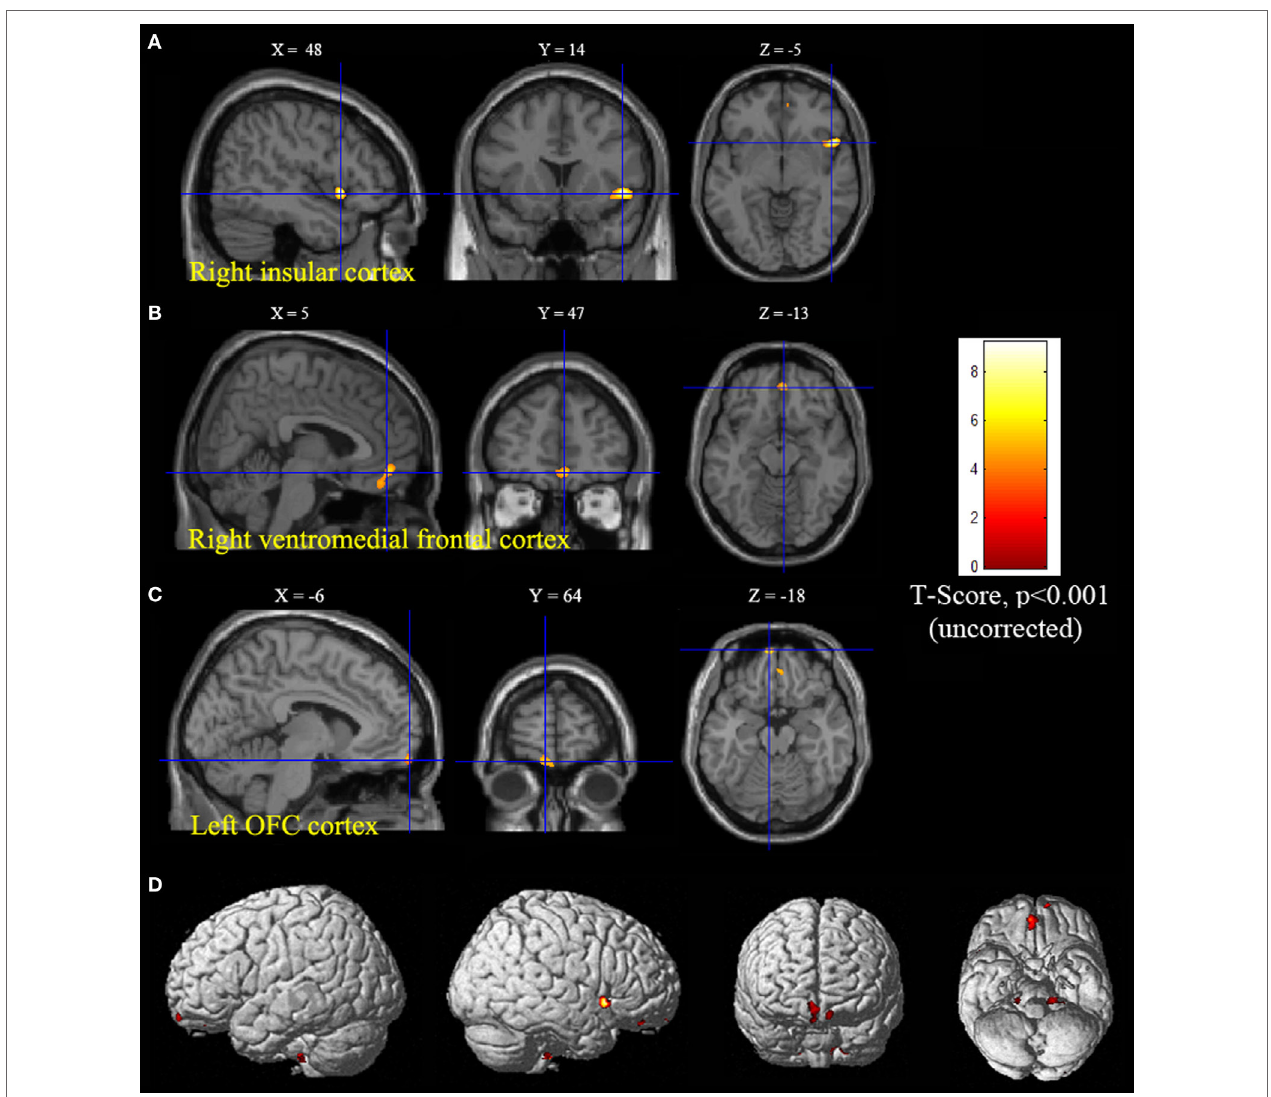
FigUre 4 | Significant hypometabolism in patients with HMS1, in comparison to patients with HMS2. More extensive hypometabolic areas in HMS1 than HMS2 were found, including right insular cortex (a) , right ventromedial frontal cortex (b) , and left orbitofrontal cortex (c) . Note that PET images in patients with right-sided epileptogenic zones were transposed horizontally, and all hypermotor seizures (HMS) were supposed to originate from left hemisphere. The color scale means T scores for the slice view. The superacial view of significant results was presented in the 3D map (D) and color bar was not